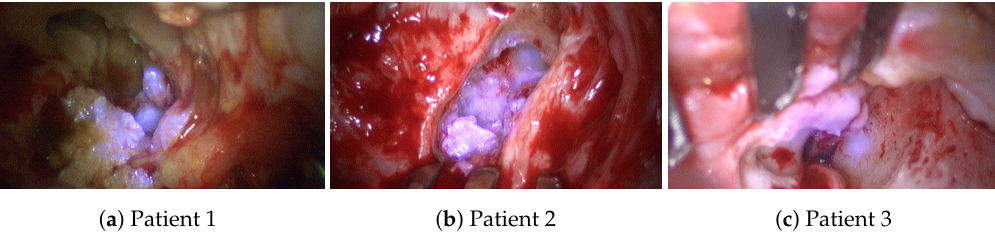
Figure 9. Augmented cholesteatoma visualization for the study group of three patients: ( a , b ) Visualizations using the spectral information at λ = 420 nm. ( c ) Visualizations using the spectral information at λ = 400 nm. All marked regions identified by the surgeon as cholesteatoma in the broad-band images (cf. Figure 4) before and after spectral acquisition correspond to bluish structures in the improved RGB visualization. To confirm the diagnosis of the surgeon, all identified and removed tissue samples are analyzed using normal histological